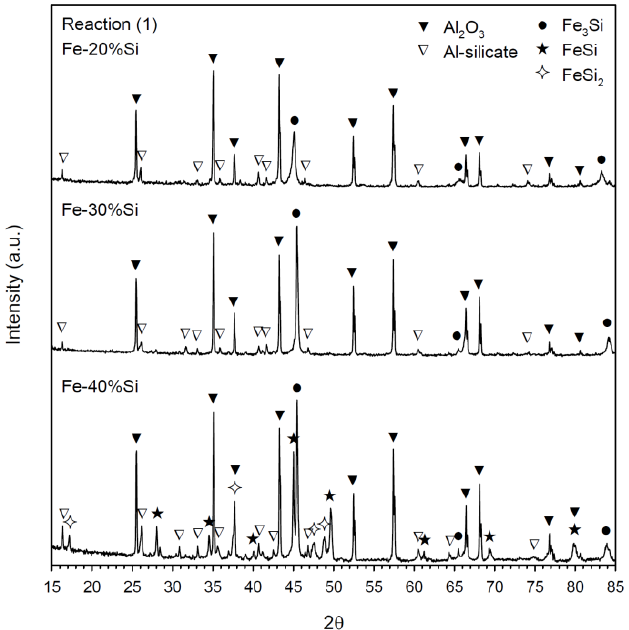
Figure 4. XRD patterns of SHS products of Reaction (1) with Si percentages of Fe-20% Si, Fe-30% Si, and Fe-40% Si.